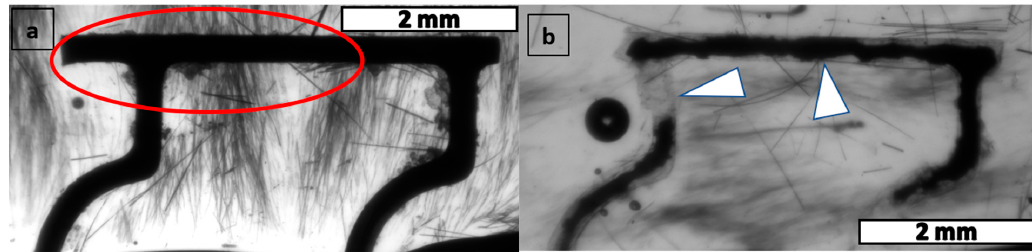
Figure 17. Optical images (taken on a light microscope) of ribbon segments after in vivo implantation for 15 days, removal with skin, tissue fixation, and tissue clearing. ( a ) An uncoated Zn segment was basically intact. The red circle directs attention to segments of the stents that were intact after 15 days;